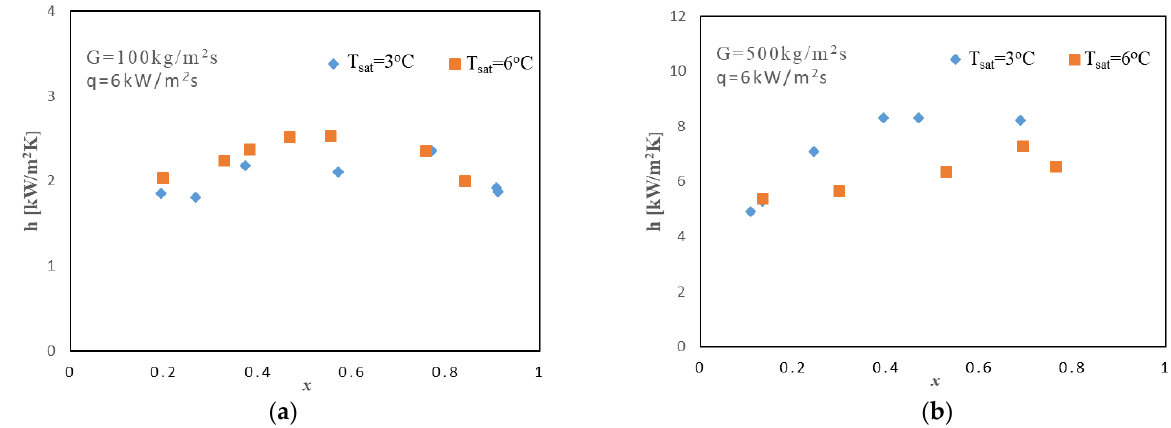
Figure 4. Effect of heat flux on heat transfer coefficient at ( a ) G = 200 kg/(m 2 s) ( b ) G = 500 kg/(m 2 s). Figure 5a,b compared the heat transfer coefficient of R448A at a saturated temperature of 3 ◦ C and 6 ◦ C.